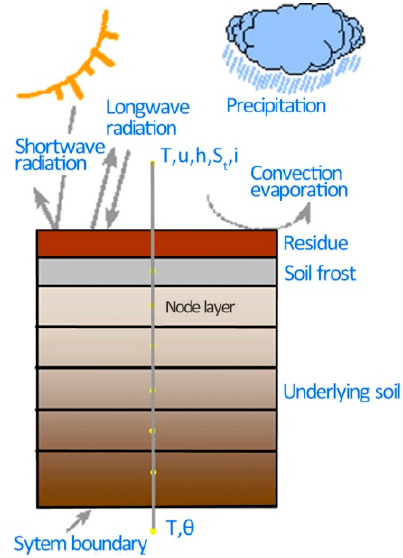
Figure 3. Physical description of the SHAW model (T: temperature; u: wind speed; h: relative humidity; S t : solar radiation; i: precipitation; T : soil temperature; θ : soil water content).